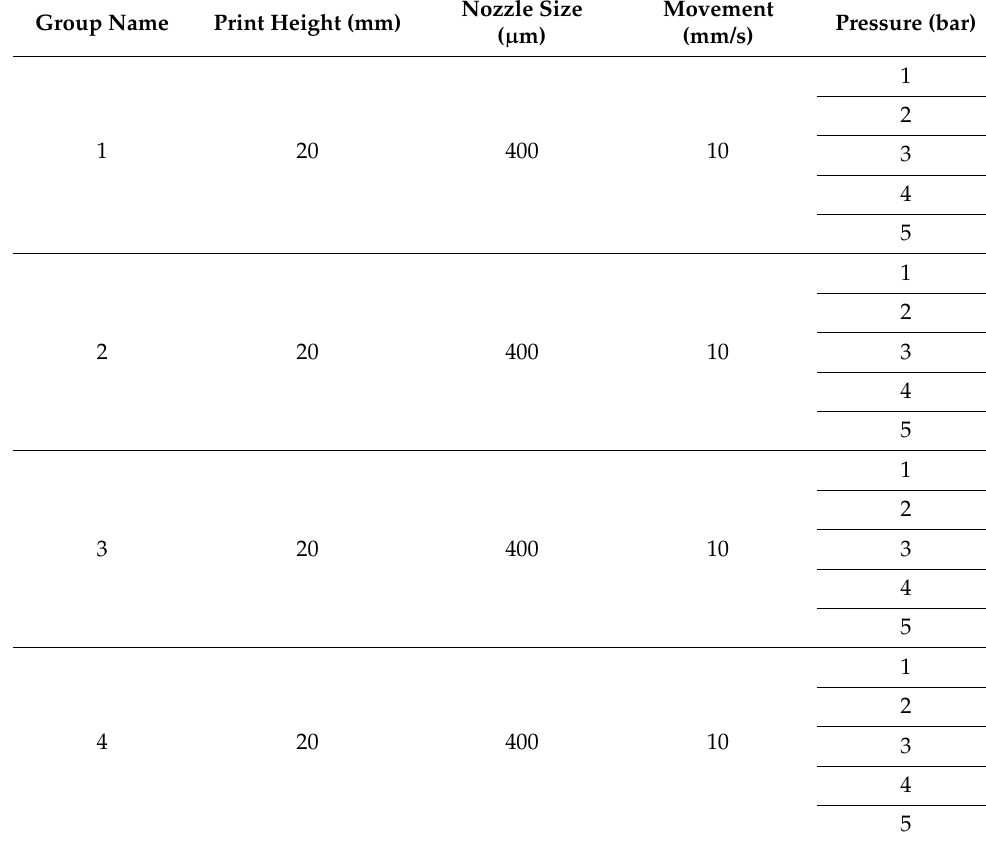
Table 2. Printed parameters of each composite group.